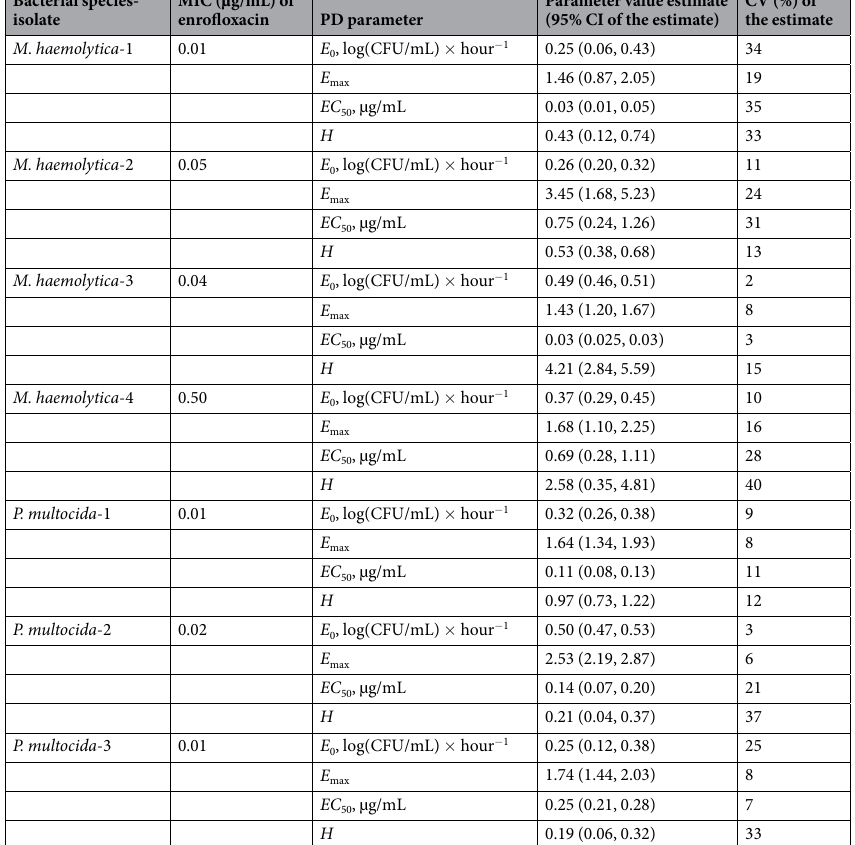
Table 1. Parameter values of the sigmoid E max pharmacodynamic (PD) models for the fluoroquinolone enrofloxacin for four isolates of Mannheimia haemolytica and three isolates of Pasteurella multocida from bovine respiratory disease